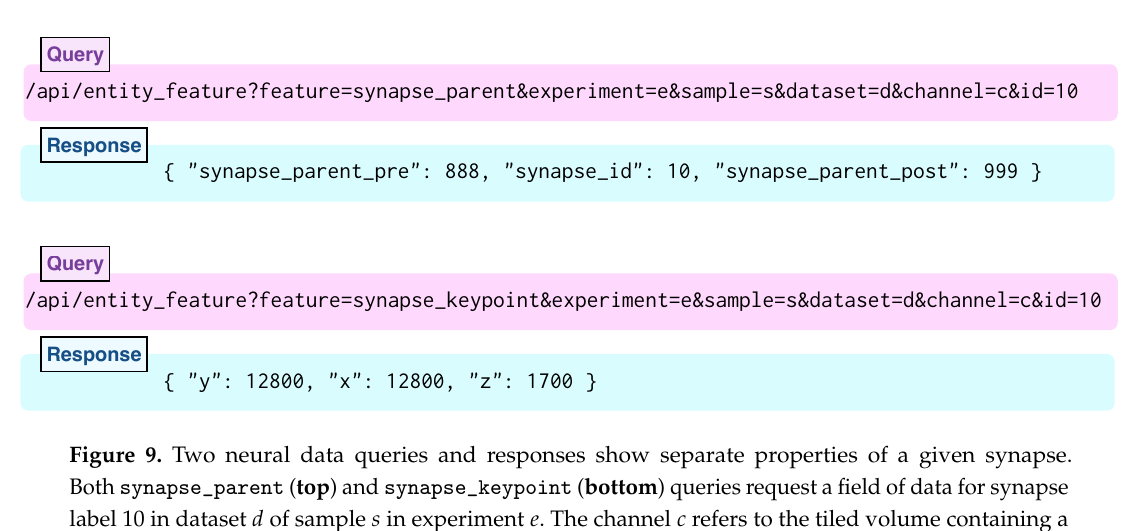
Figure 9. Two neural data queries and responses show separate properties of a given synapse. Both synapse_parent ( top ) and synapse_keypoint ( bottom ) queries request a field of data for synapse label 10 in dataset d of sample s in experiment e . The channel c refers to the tiled volume containing a reconstruction of synapse segments. The top request returns both neuron segment labels representing the presynaptic input and postsynaptic output of the provided synapse. The bottom request returns the coordinates of the center of the requested